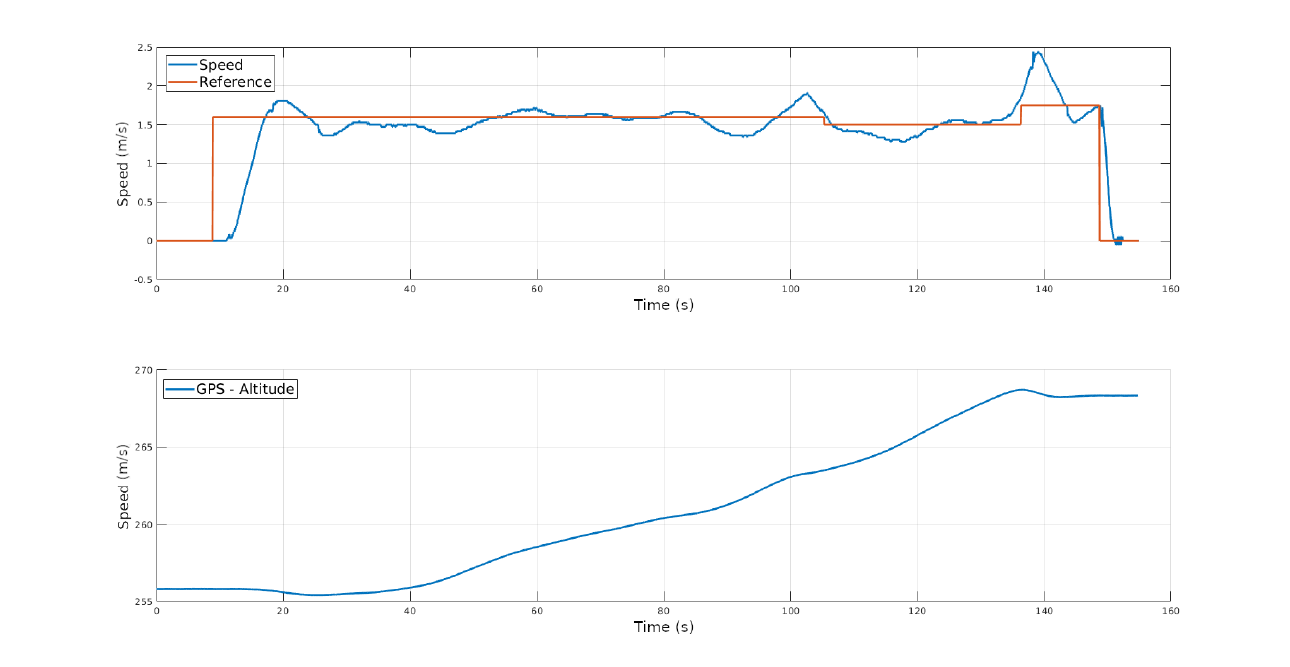
Figure 18. Low-level control speed